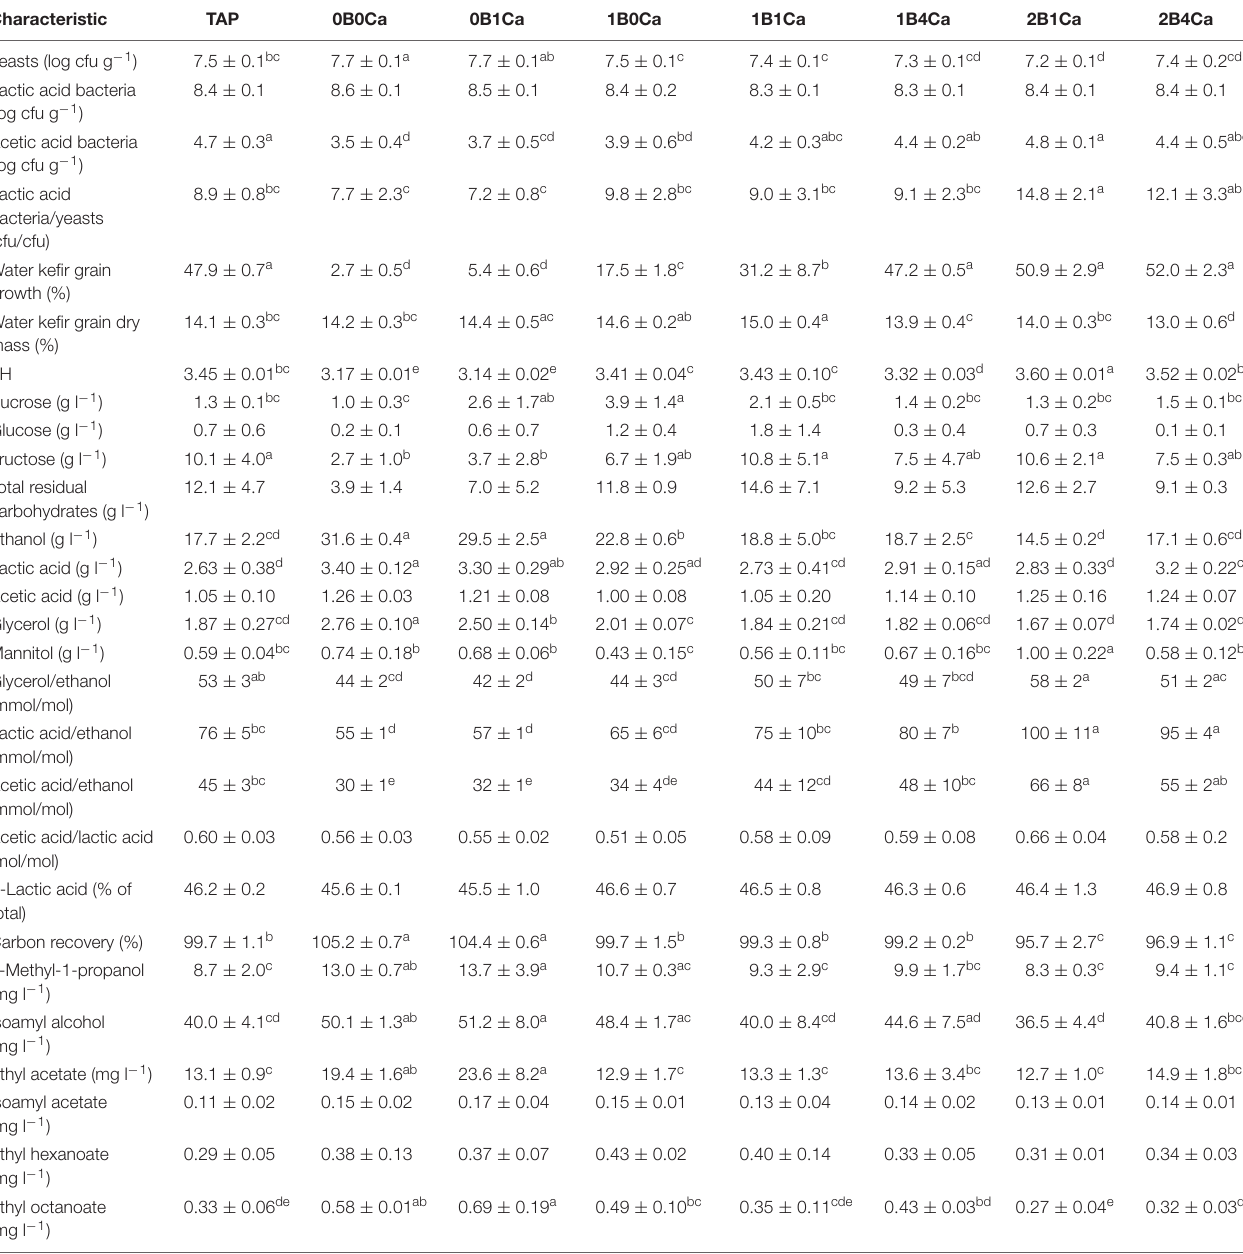
TABLE 3 | Characteristics of eight water kefir fermentation series differing in the buffer capacity and calcium concentration of the water used for fermentation at the end of backslopping step 8 [control fermentation with tap water (TAP); fermentations with different buffer capacity, and concomitant increasing calcium concentrations (0B0Ca and 0B1Ca; 1B0Ca, 1B1Ca, and 1B4Ca; and 2B1Ca and 2B4Ca); and fermentations with different calcium concentrations and concomitant increasing buffer capacity (0B0Ca and 1B0Ca; 0B1Ca, 1B1Ca, and 2B1Ca; and 1B4Ca and